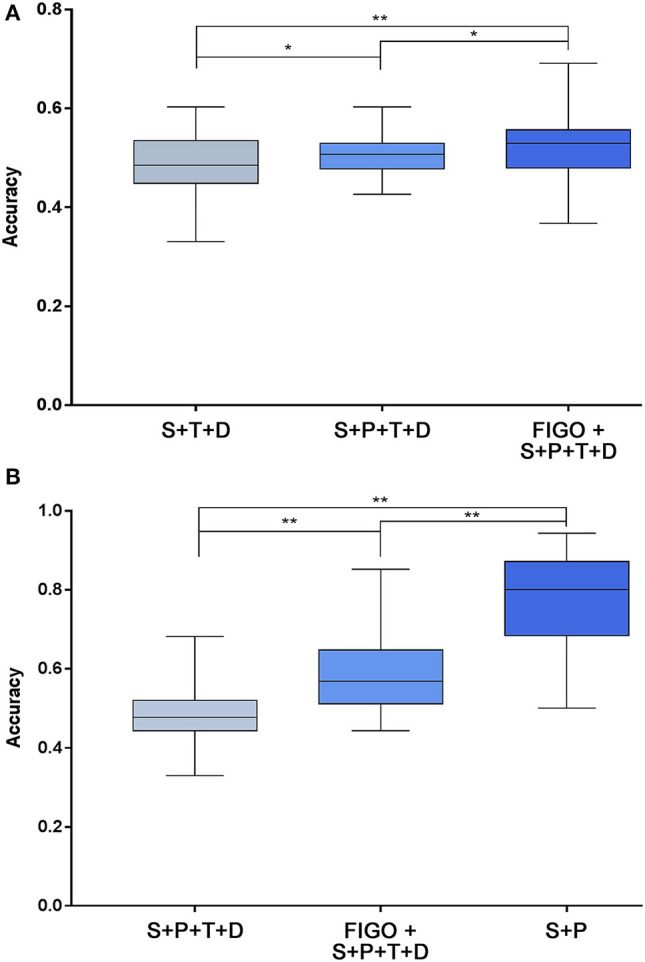
Prediction accuracy of high-risk factors for recurrence (A) and death (B) based on the SVM algorithm. After combining the screened high-risk factors, the SVM algorithm was used to predict the recurrence and death of each patient. (A) Shows the predictive accuracy of a combination of 3 independent high-risk factors (status of lymph node + parametrium involvement + deep of cervical stromal invasion), 4 high-risk factors (status of lymph node + parametrium involvement + tumor size + deep of cervical stromal invasion), and 5 high-risk factors (FIGO stage + status of lymph node + parametrium involvement + tumor size + deep of cervical stromal invasion) on adverse endpoints of recurrence. There are significant differences in accuracy between the three groups (P < 0.05). (B) Shows the predictive accuracy of a combination of two independent high-risk factors (status of lymph node + parametrium involvement), 4 high-risk factors, and 5 high-risk factors (same as A) on adverse endpoints of death. There were also significant differences in accuracy between the three groups (P < 0.001). *P < 0.01 and **P < 0.001. SVM, support vector machine; P, parametrium involvement; T, tumor size; D, deep of cervical stromal invasion; S, status of lymph nodes; FIGO, International Federation of Gynecology and Obstetrics.